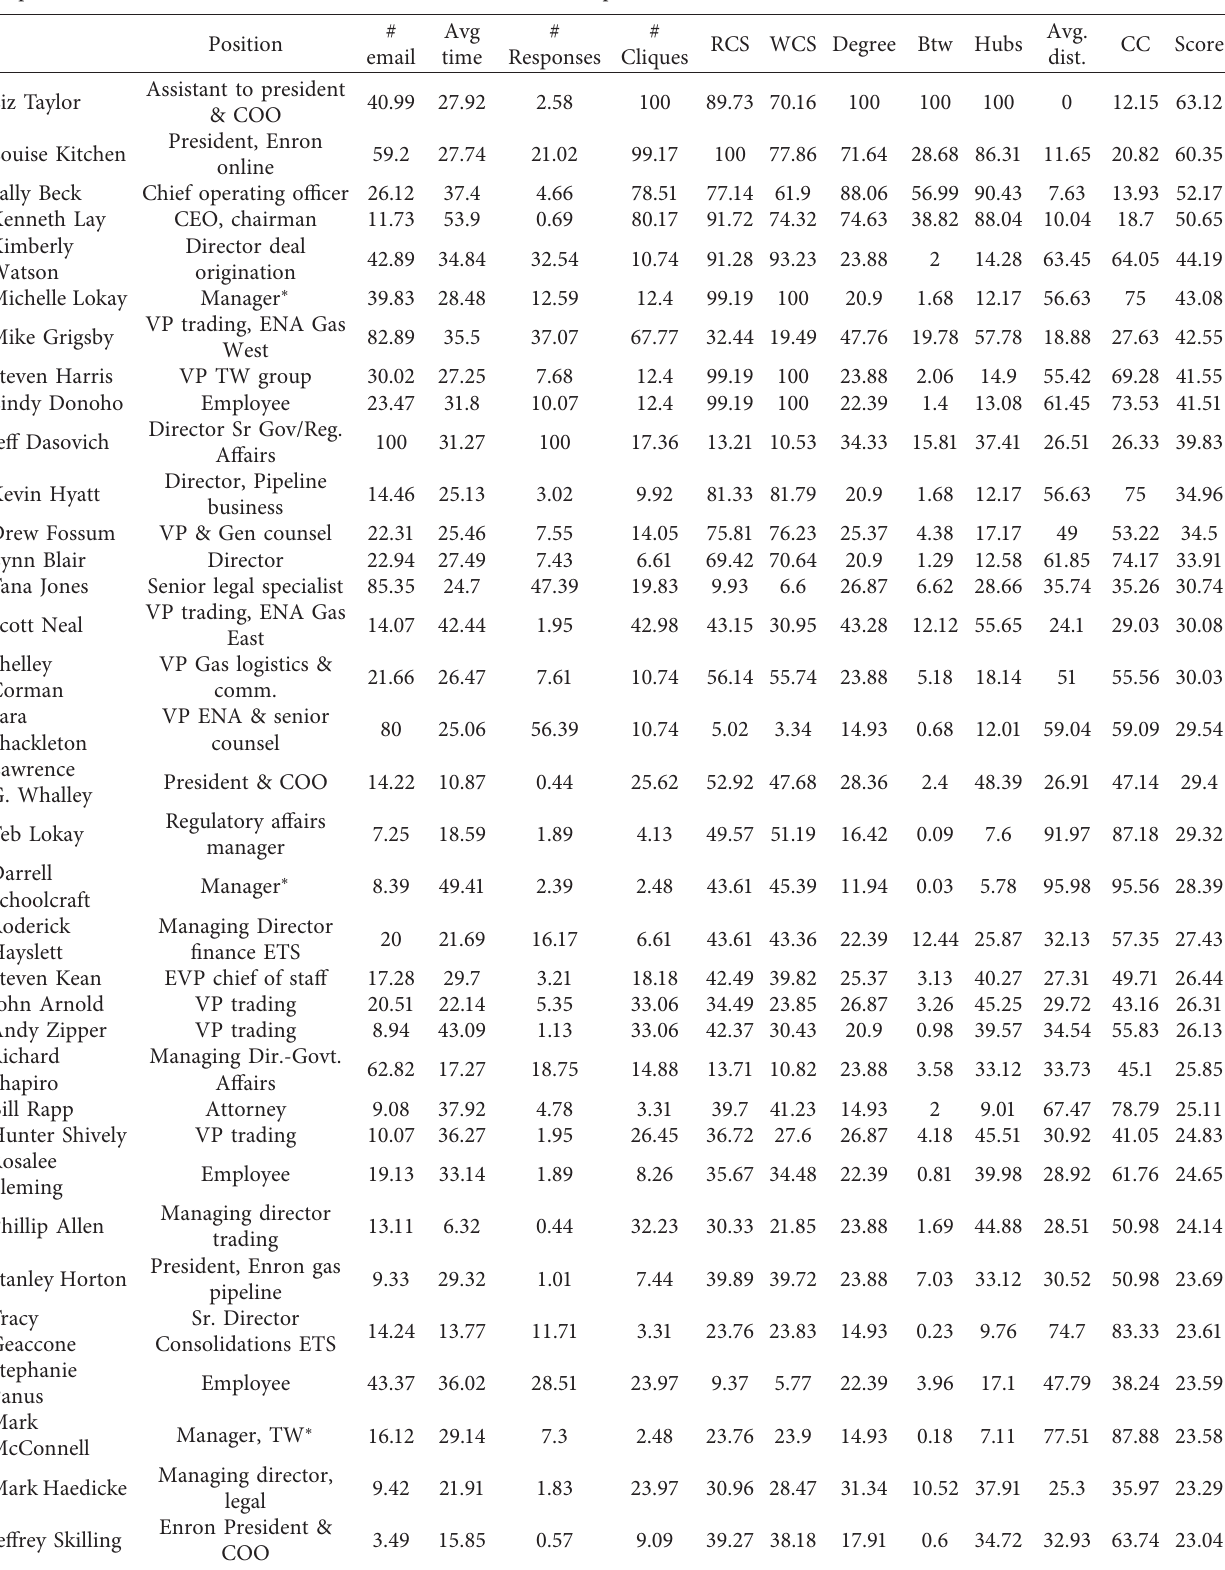
Table 9: CorpRank scores of employees: Enron. TW: TransWestern pipeline company, N.A.: North America, V.P.: Vice President, E: Enron, RCS: raw clique score, WCS: weighted clique score, Btw: betweenness, Avg. Dist.: average distance, CC: clustering coefficient, Score: CorpRank score. ∗ ∗ indicates that the content of emails infers the